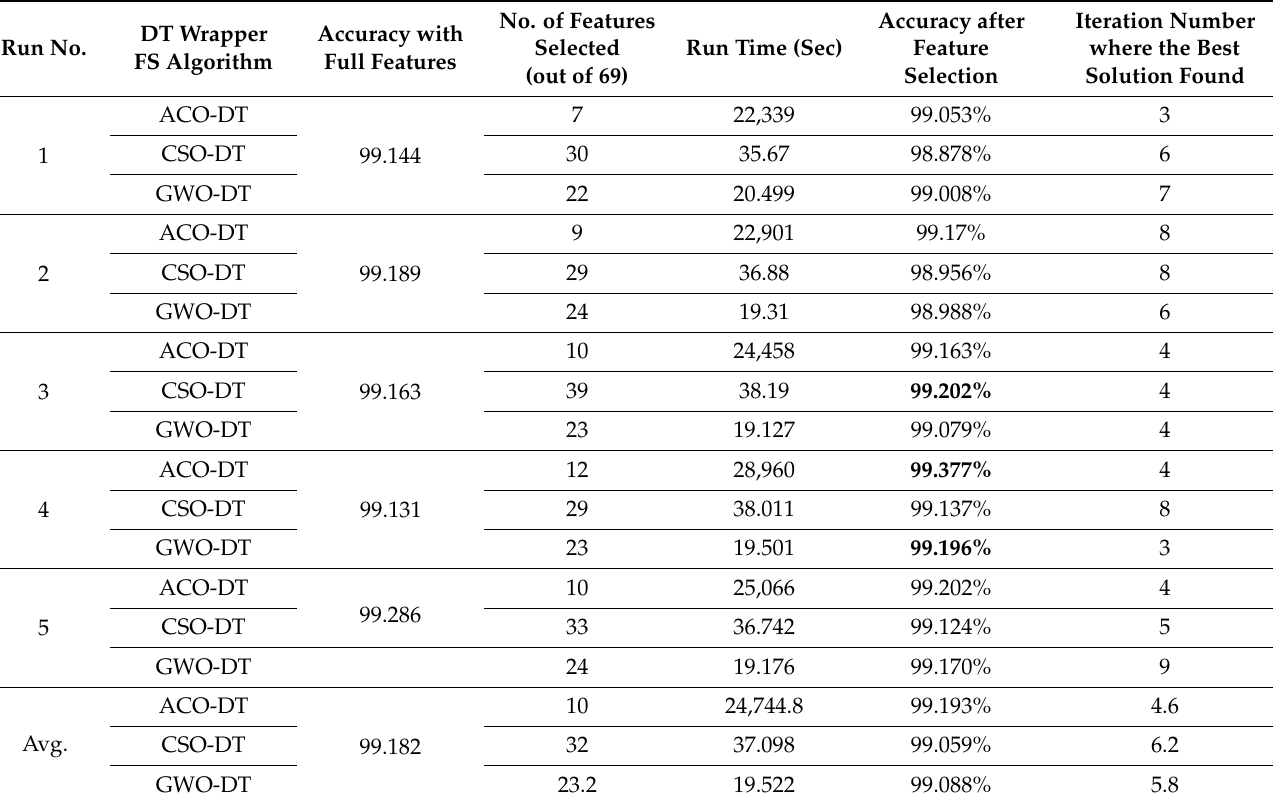
Table 14. Evaluation of ACO-DT, CSO-DT, and GWO-DT on the proposed SOMLAP dataset.